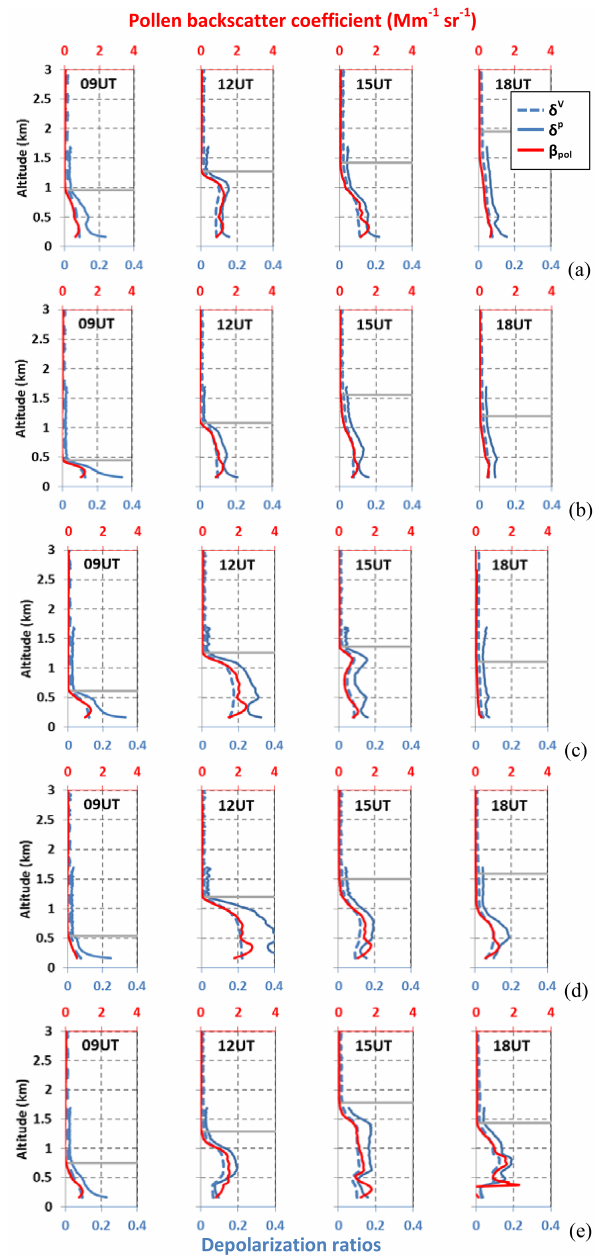
Figure 4. Diurnal time series of the hourly vertical distribution of the pollen backscatter coefficient ( β pol ) , the volume depolariza- tion ratio ( δ V ) , and the particle depolarization ratio ( δ p ) on (a) 27, (b) 28, (c) 29, (d) 30, and (e) 31 March 2015. The grey horizontal lines indicate the pollen layer height, h pol .